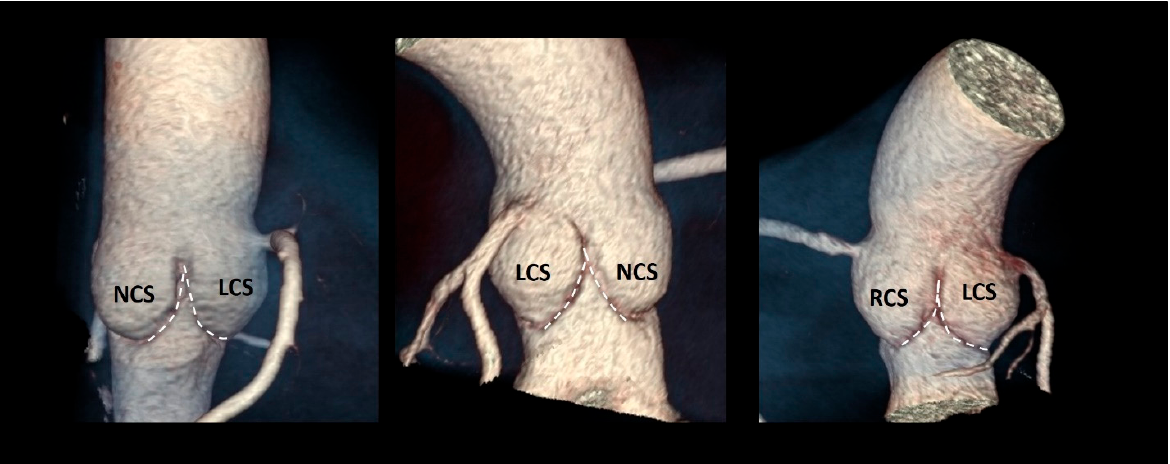
Figure 7. The three inter-leaflets triangles visualized with CT volume rendering format (dotted line). NCS = non-coronary sinus; LCS = left coronary sinus; RCS = right coronary sinus.